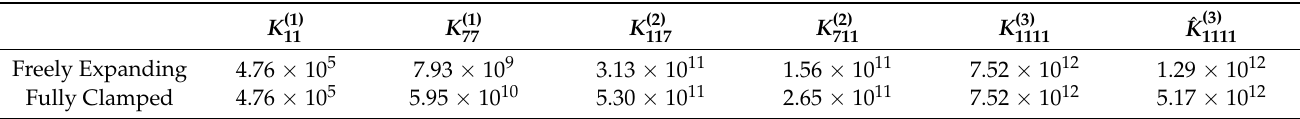
Table 4. ROM coefficients relating to the first linear mode (“1”) and first dual (“7”). Freely expanding and fully clamped plates.